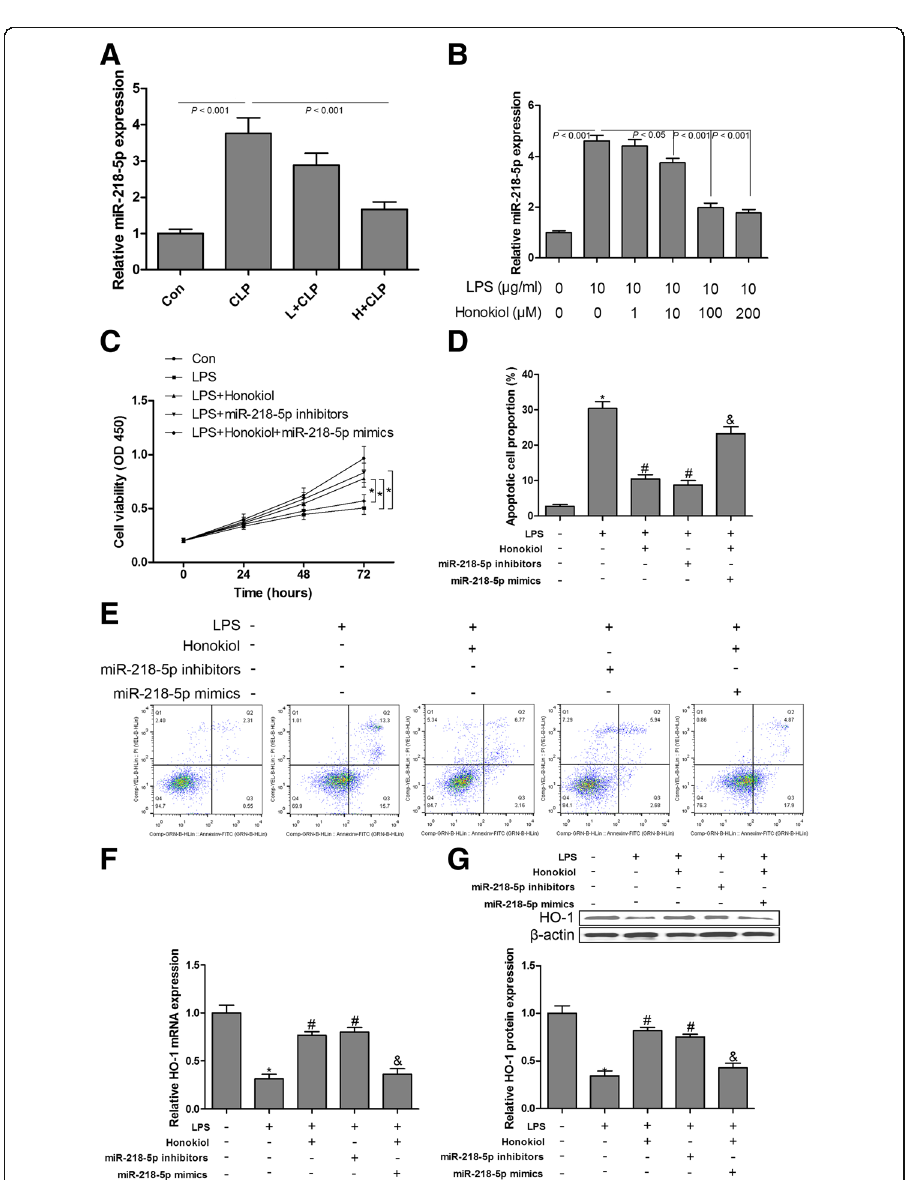
Fig. 7 Honokiol blocks LPS-induced cell growth inhibition and apoptosis by targeting miR-218-5p/HO-1. The expression levels of miR-218-5p were measured using RT-qPCR assays in the kidney from septic mice with or without honokiol treatment ( a ) and in LPS-stimulated GMCs with or without honokiol treatment ( b ). GMCs were exposed to different conditions, cell viability was measured by CCK-8 assay ( c ); cell apoptosis was performed by flow cytometry ( d and e ); the mRNA ( f ) and protein ( g ) expression levels of HO-1 were measured by RT-qPCR and western blotting, respectively. Values are expressed as mean ± SEM, n = 3 in each group. * P < 0.05 versus control group; # P < 0.05 versus LPS treated group; & P < 0.05 versus honokiol+ LPS treated